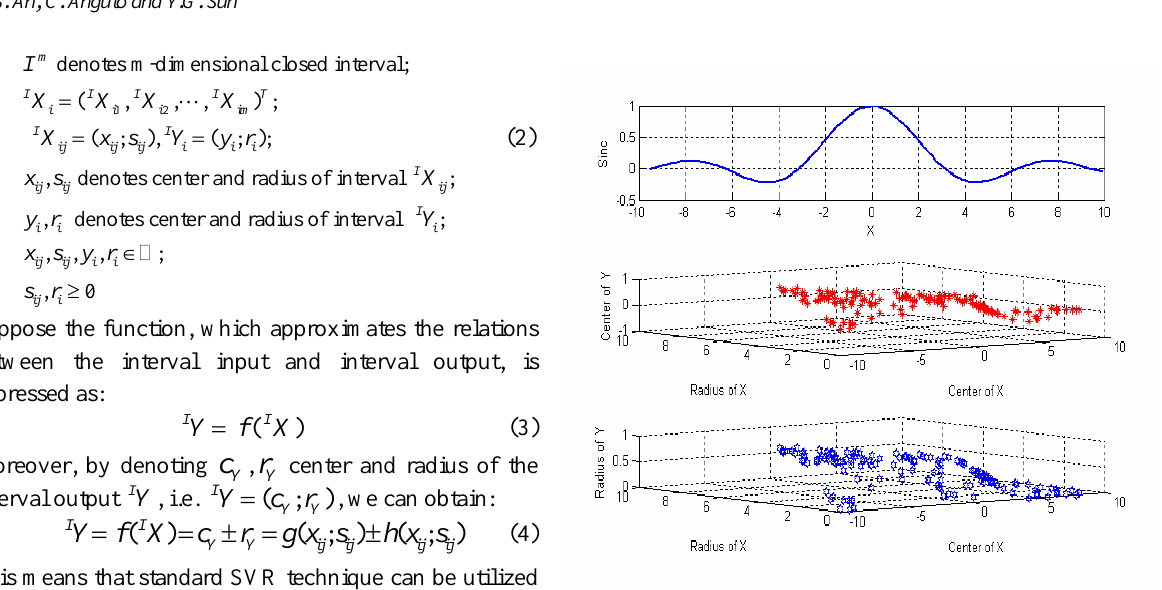
Fig. 1. This is Sinc function and generated sample data.